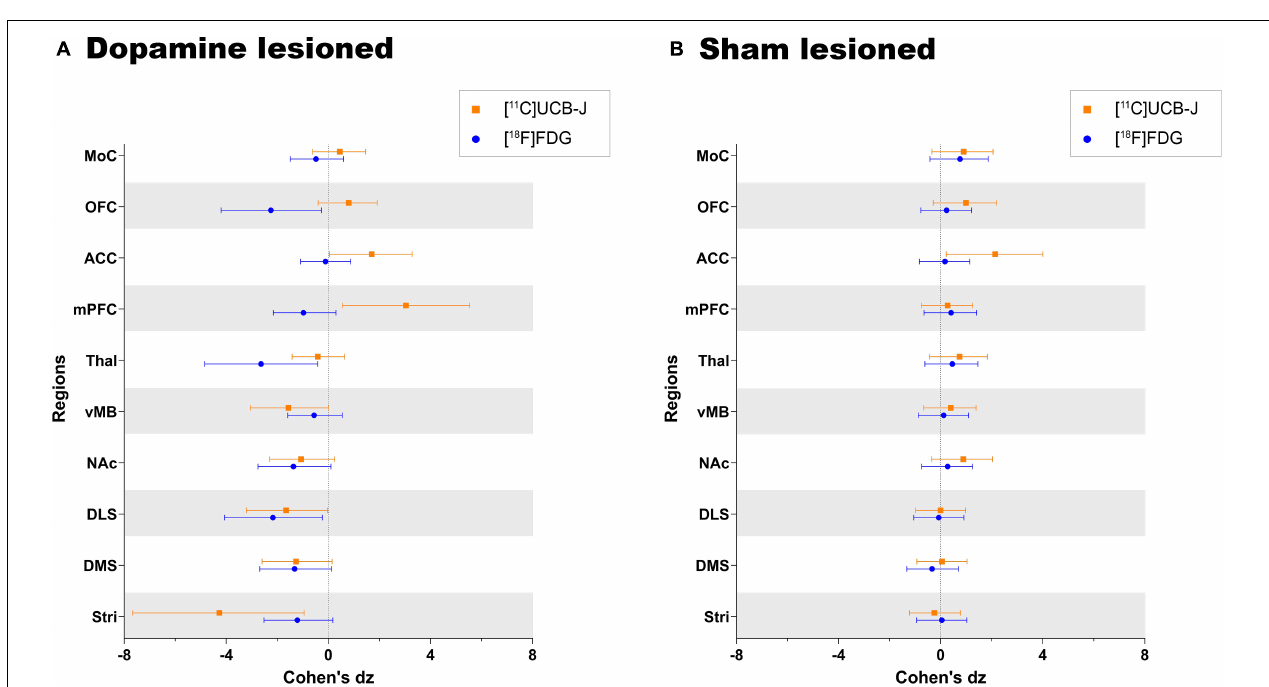
FIGURE 6 | Direct comparison of effect size (Cohen’s dz values) as measured by [ 11 C]UCB-J and [ 18 F]FDG PET in (A) dopamine lesioned and (B) sham lesioned animals. All regions within the dopamine and sham lesioned animals in the study are compared. Error bar denotes the mean and the 95% confidence interval. Stri = striatum, DMS = dorsomedial striatum, DLS = dorsolateral striatum, NAc = nucleus accumbens, vMB = ventral midbrain, Thal = thalamus, mPFC = medial prefrontal cortex, ACC = anterior cingulate cortex, OFC = orbitofrontal cortex, and MoC = motor cortex.